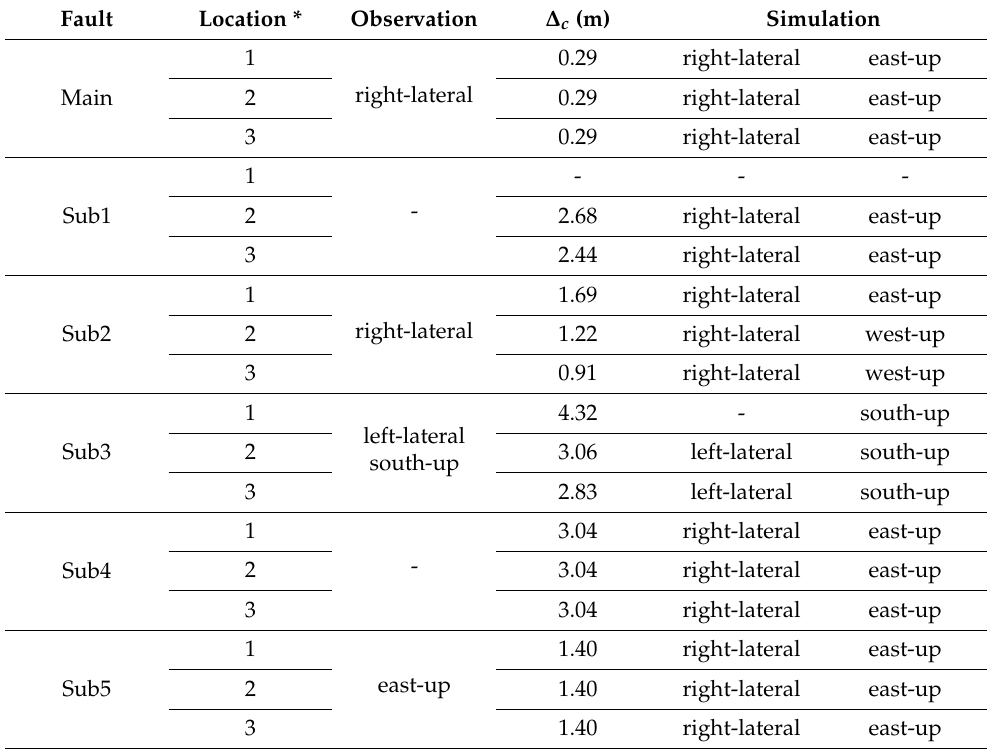
Table 2. Slip sense and ∆ c on each fault